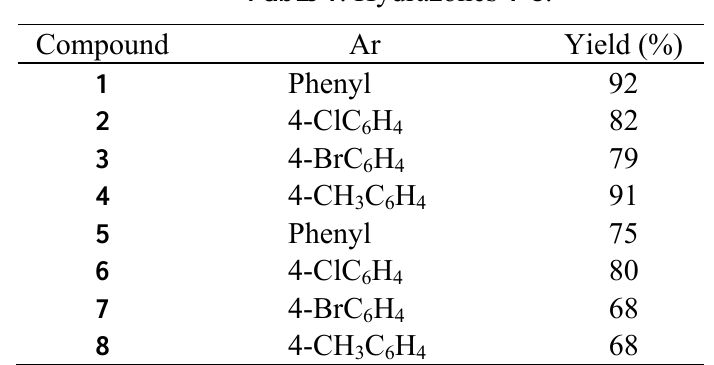
Table 1 . Hydrazones 1-8